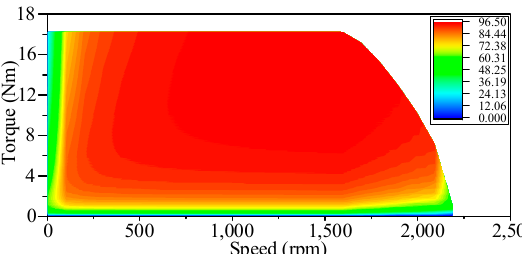
Figure 15. Torque performance of CPMM. ( a ) Cogging torque. ( b ) On-load torque.